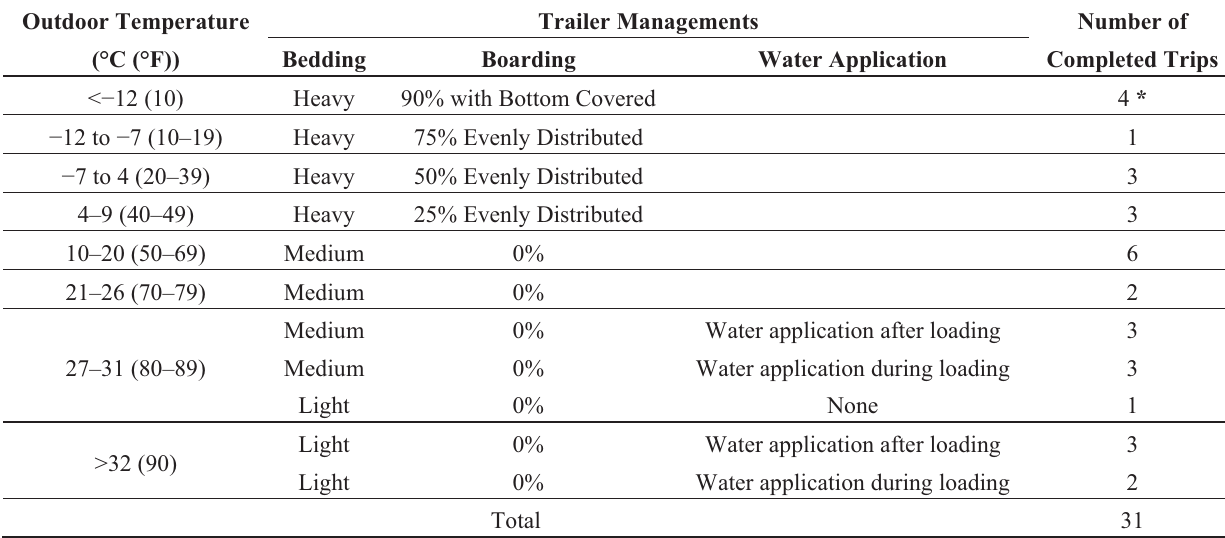
Table 3. Summary of outdoor temperature and trailer management under the TQA guidelines for 31 completed monitoring